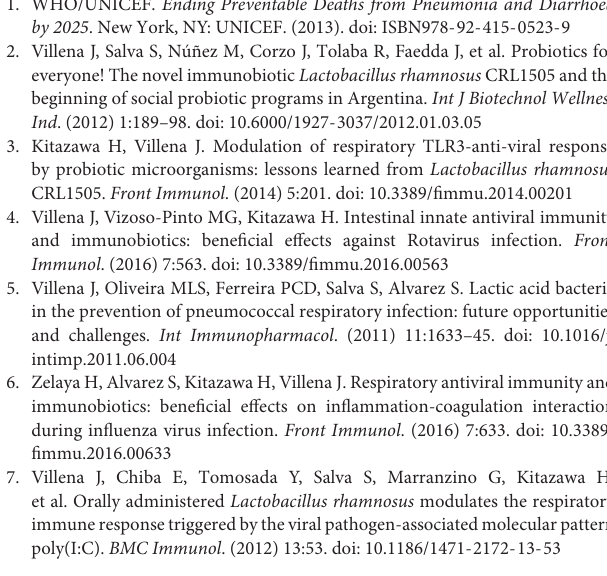
FIGURE S1 | Expression of interferon ( IFN ) - α , and antiviral factors ( TLR3, RIG-1 and OAS1 ) genes in porcine intestinal epithelial (PIE) cells treated with Lactobacillus rhamnosus CRL1505, L. rhamnosus IBL027, L. rhamnosus CRL576, Lactobacillus plantarum C RL1506, L. plantarum MPL16, or L. plantarum CRL681 and challenged with the viral molecular associated pattern poly(I:C), analyzed by qPCR. PIE cells with no lactobacilli treatment and stimulated with poly(I:C) were used as controls. The results represent data from three independent experiments. Letters indicate significant differences ( P < 0.05), a < b < c. FIGURE S2 | Expression of genes involved in prostaglandins biosynthesis ( PTGS2, PLA2G4A, PTGER4 and PTGES ) in porcine intestinal epithelial (PIE) cells treated with Lactobacillus rhamnosus CRL1505, L. rhamnosus IBL027, L. rhamnosus CRL576, Lactobacillus plantarum CRL1506, L. plantarum MPL16, or L. plantarum CRL681 and challenged with the viral molecular associated pattern poly(I:C), analyzed by qPCR. PIE cells with no lactobacilli treatment and stimulated with poly(I:C) were used as controls. The results represent data from three independent experiments. Letters indicate significant differences ( P < 0.05), a < b < c. FIGURE S3 | Global overview of the signaling pathways and immune genes differentially regulated in PIE cells treated with L. rhamnosus CRL1505 or L. plantarum MPL16 and challenged with poly(I:C). Detailed immunomodulatory mechanisms were previously studied for L. rhamnosus CRL1505 (16, 20). FIGURE S4 | Levels of intestinal interferons (IFN- β and IFN- γ ), proinflammatory cytokines (TNF- α and IL-6) and IL-10 in mice orally treated with Lactobacillus rhamnosus CRL1505, L. rhamnosus IBL027, L. rhamnosus CRL576, Lactobacillus plantarum CRL1506, L. plantarum MPL16, or L. plantarum CRL681 (10 8 cells/mouse/day for five consecutive days). Mice with no lactobacilli treatment were used as controls. Immune factors were evaluated on day 6. The results represent data from three independent experiments ( n = 6 per group). Letters indicate significant differences ( P < 0.05), a < b < c.